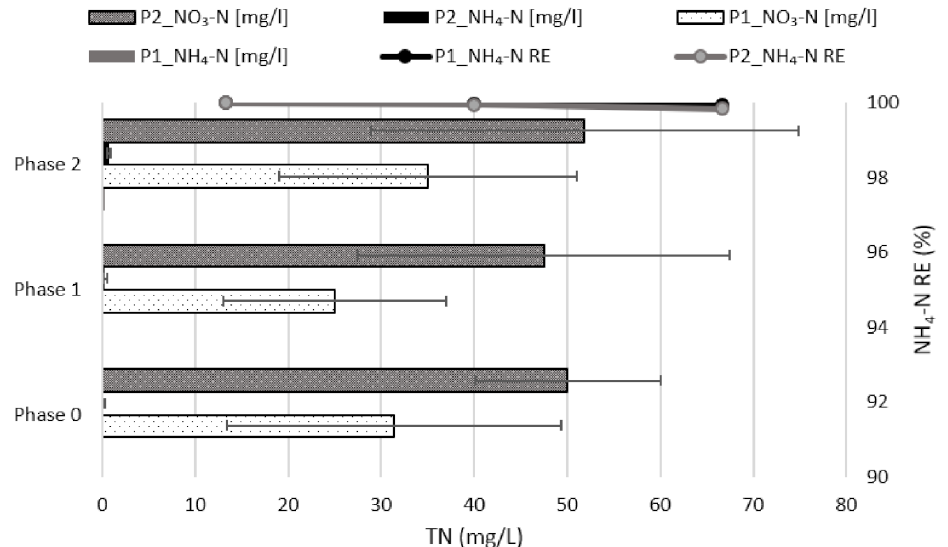
Figure 7. Overall TN (NH 4 -N and NO 3 -N) concentration and NH 4 -N removal efficiency in the permeate of L-1 and L-2 after activated sludge and UF process in their respective